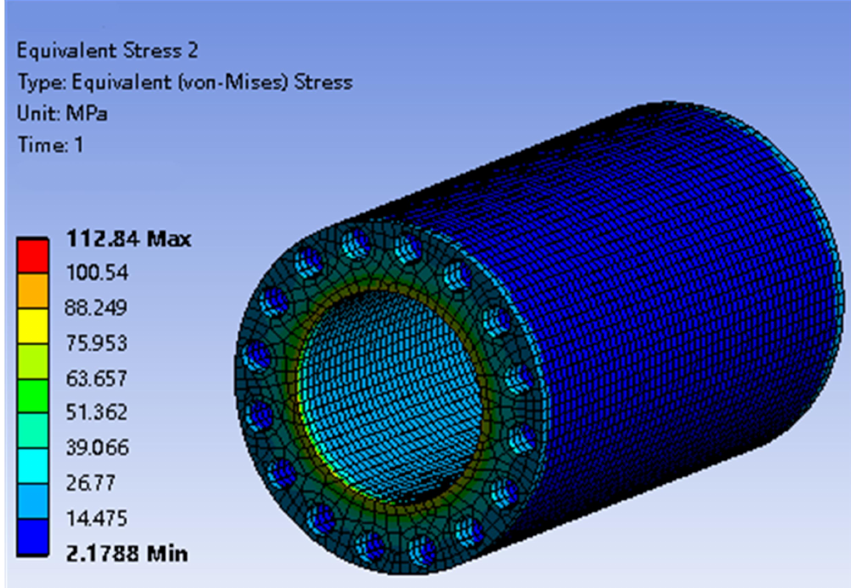
Figure 13. Mechanical Stress of the Laminated